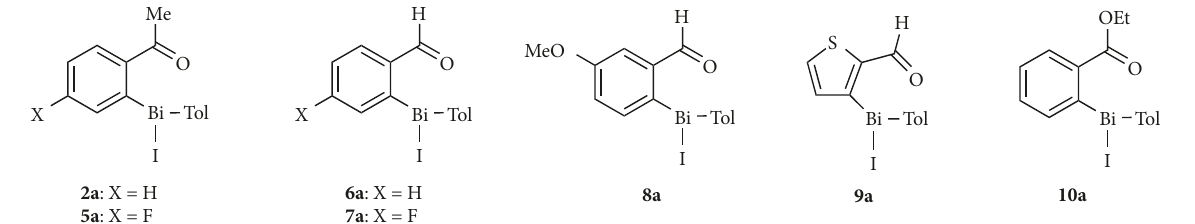
6a : X = H 7a : X = F Scheme 3: Hypervalent iodobismuthanes functionalized with a carbonyl